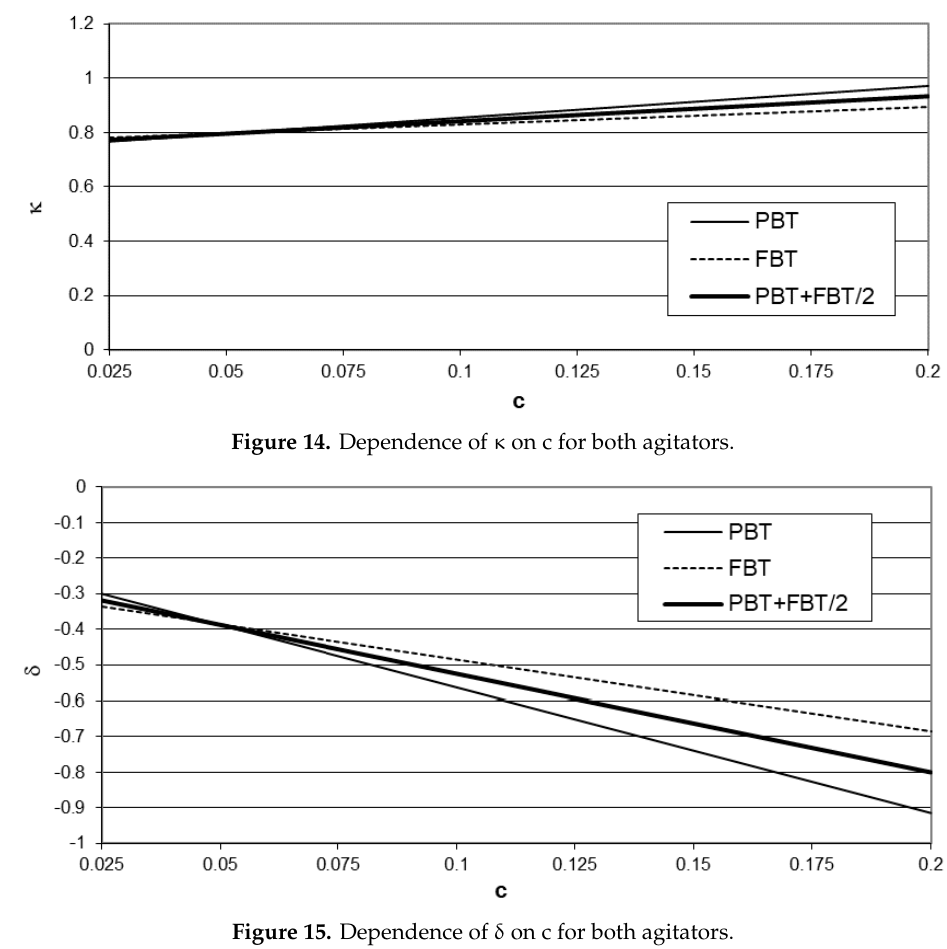
Figure 15. Dependence of δ on c for both agitators.